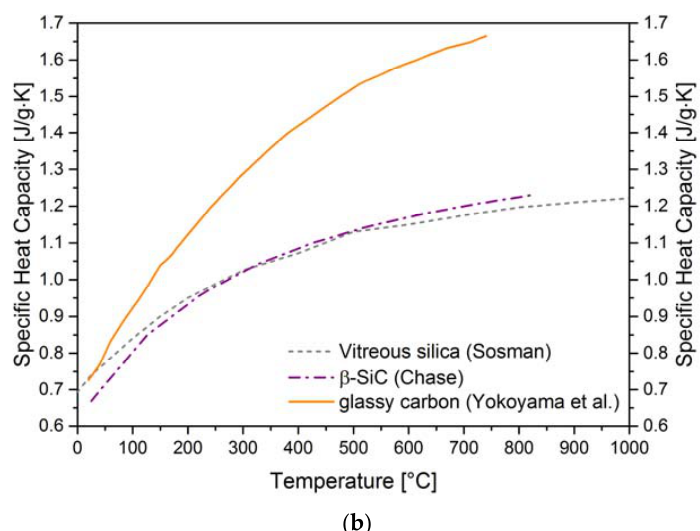
Figure 4. Temperature-dependent specific heat capacities of SiOC glasses and glass ceramics ( a ). Points represent the measured values; the solid lines represent eye guidelines. The inset details the specific heat capacities in the temperature range of 400 °C to 1000 °C. The values for glassy carbon [44], vitreous silica [42], and β‐ SiC [43] are plotted for comparison ( b ).